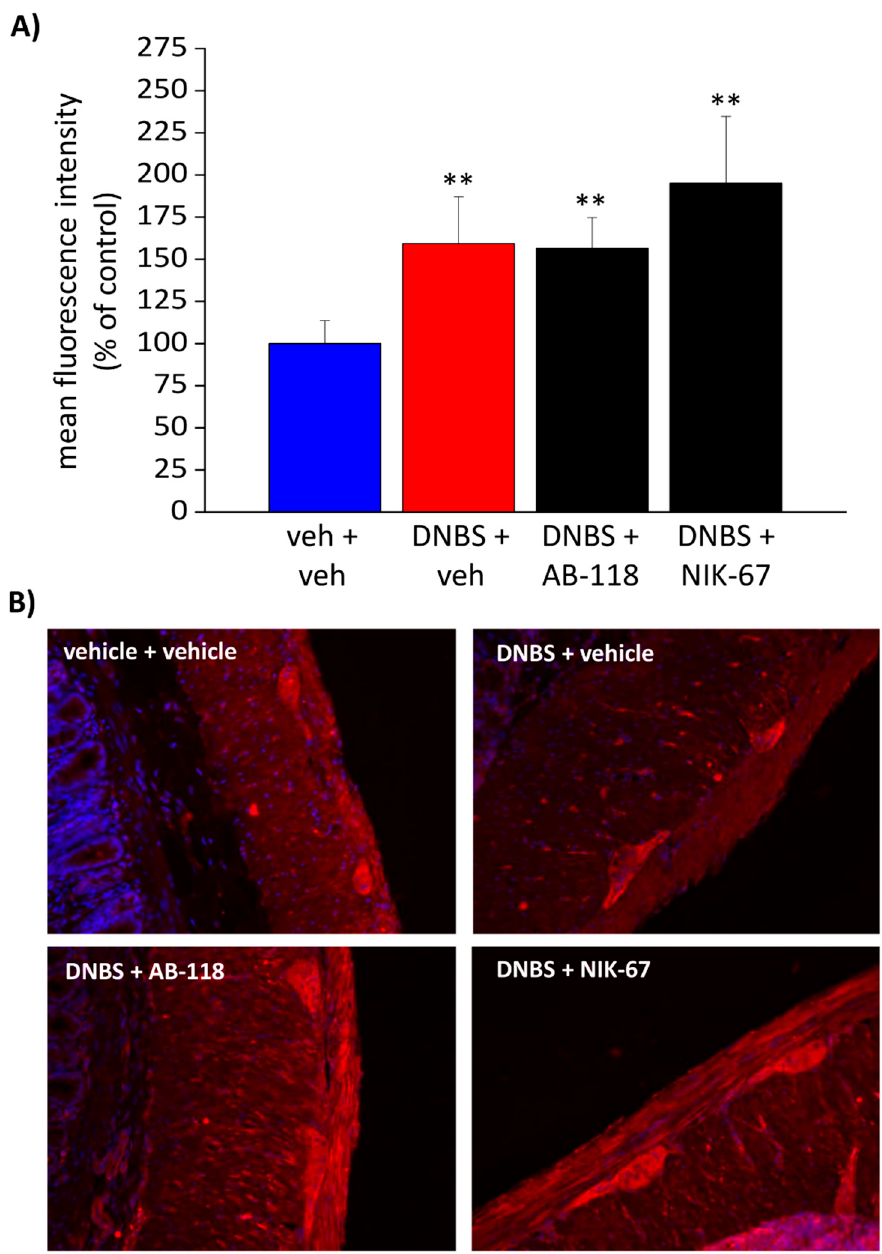
Figure 7. Effect of DNBS injection and AB-118 or NIK-67 administration on CA IV expression in colon myenteric plexus. The distribution of CA IV on colon sections was evaluated by immunofluorescence on tissue sections. The mean fluorescence intensity relative to the entity of CA IV expression in the myenteric plexus was expressed as a percentage of the control ( A ). Representative images of the colon myenteric plexus were reported (scale bar: 40×; B ). The values are the means ± SEM of the measurements of individual animals (at least five images each) from the different experimental groups. ** p < 0.01 vs. vehicle + vehicle group.